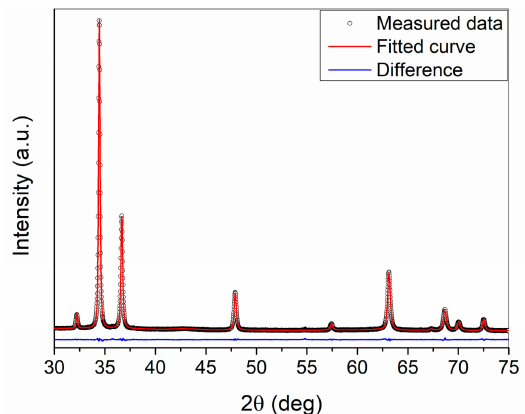
Figure 6. XRD profile of the MgTN_3h_N3 sample (at half radius) fitted by the convolutional multiple whole profile (CMWP) method.